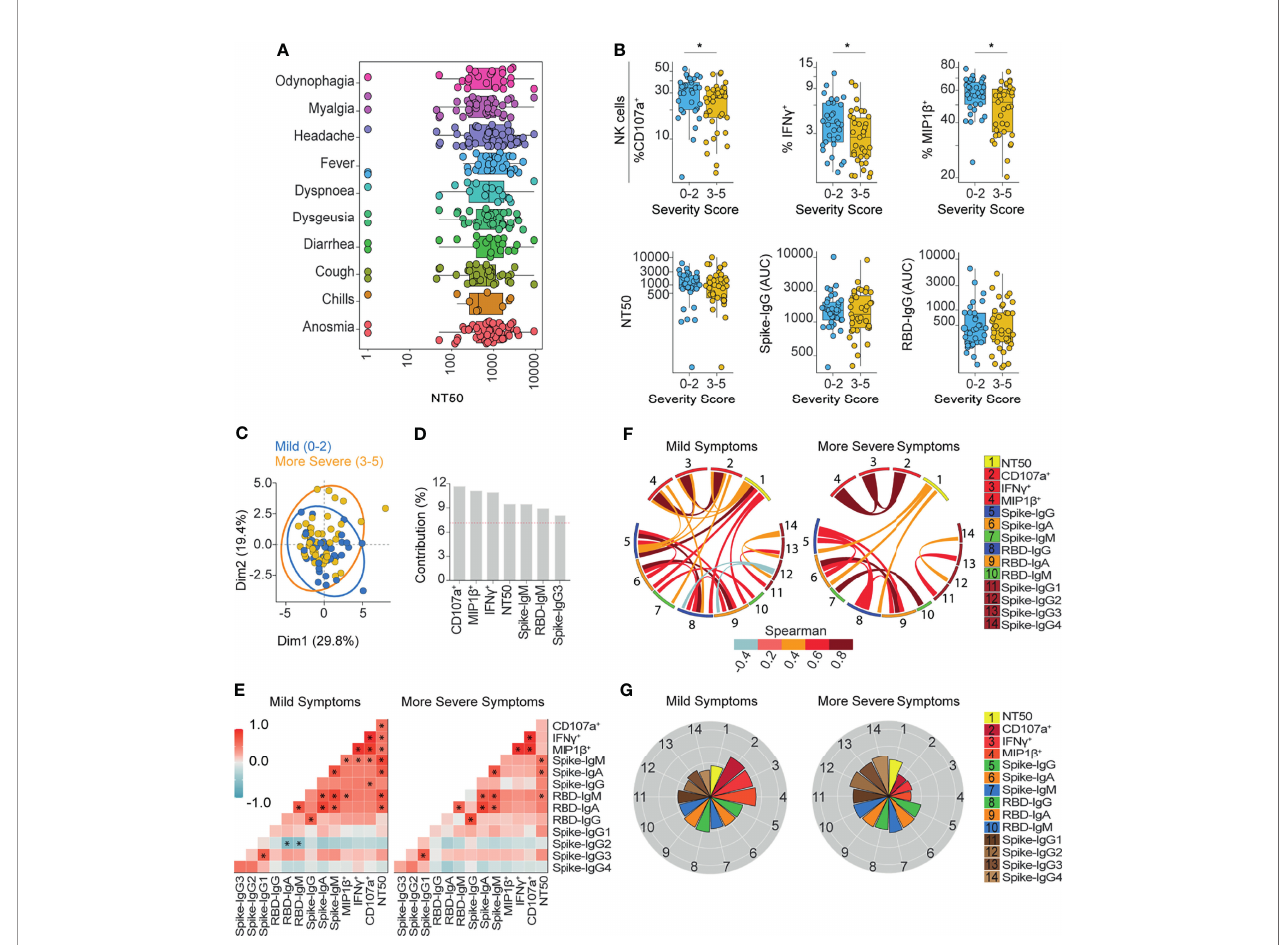
FIGURE 3 | Ab-dependent NK effector functions are prominently enriched in subjects with mild symptoms compared to subjects with more severe symptoms outpatients. (A) Box plots showing the neutralization function activity grouped according to different symptoms reported by patients at the time of diagnosis (70 donors). (B) Box plots showing differentially enriched functions and Ab titers according to the severity score of symptoms. Statistical differences were evaluated between groups of outpatients classi fi ed as 0-2 (33 samples and 33 donors) or 3-5 scores (37 samples and 37 donors), using two-tailed unpaired nonparametric Mann-Whitney test (*p value < 0.05). (C) Biplot showing the principal component analysis (PCA) depicting the “ mild ” (39 samples and 33 donors) and “ more severe ” (44 samples and 37 donors) COVID-19 outpatients, distinguished based on their severity scores, between 0 and 2 (mild) or between 3 and 5 (more severe). (D) Contribution of variables for both dimensions (1 and 2) in the PCA analysis. (E) Correlation heatmap showing the Spearman ’ s r values between the complete set of variables analyzed for mild-scored (33 samples from 33 donors) and more severe-scored (37 samples from 37 donors) groups of outpatients. The scale of blue- to-red color indicates a negative-to-positive correlation. Asterisks are shown for statistical signi fi cance of Holm-Bonferroni adjusted for multiple hypothesis testing (*p < 0.05). (F) Circos plot showing signi fi cant Spearman correlations between the pairs of variables displayed with an asterisk in (E) for mild-scored and more severe-scored groups of outpatients. The color of the links represents the magnitude of Spearman ’ s r values. (G) Polar plots showing the differential composition of humoral immune responses at different groups. Each bar represents the mean z-scores of variables for mild-scored (33 samples from 33 donors) or more severe- scored (37 samples from 37 donors)